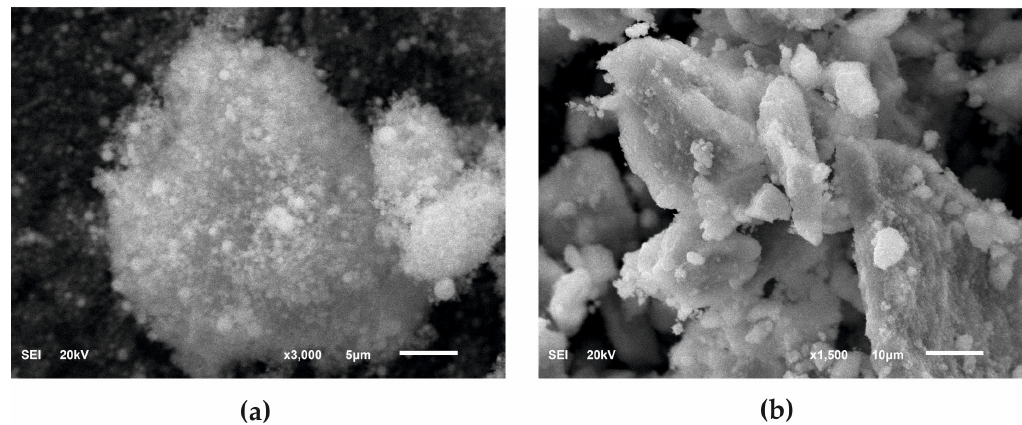
Figure 1. SEM images of HAp powders: ( a ) Nanosize particles and ( b ) microsize particles.